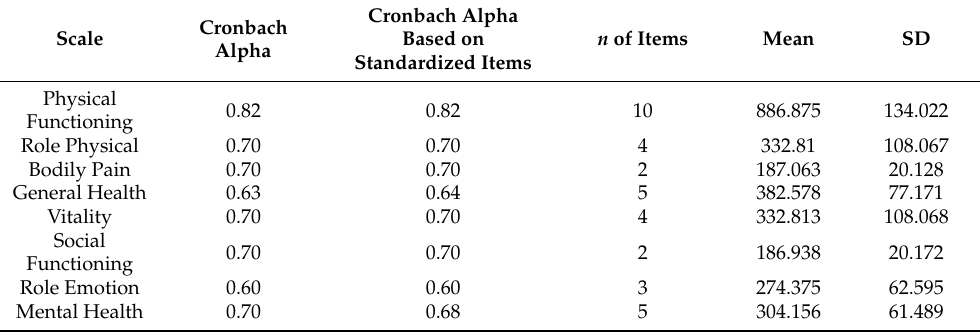
Table 2. Reliability, central tendency, and variability of the SF-36 scales.